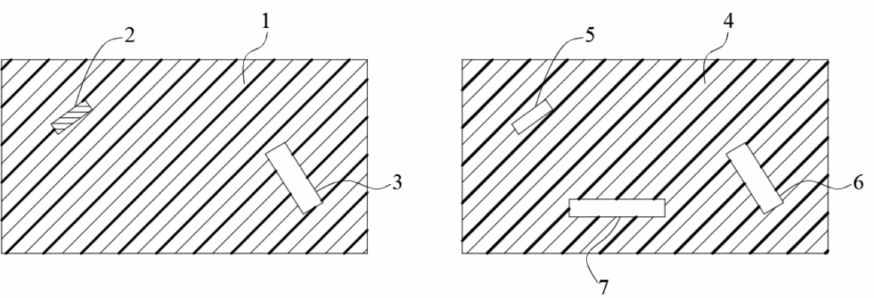
Figure 12. Electromagnetic wave-absorbing material acc. to patent. Designations: 1 and 4—dielectric binding material, such as resin or polymer; 2 and 3 and 5, 6, and 7—fibers with different physical and electrical properties (after